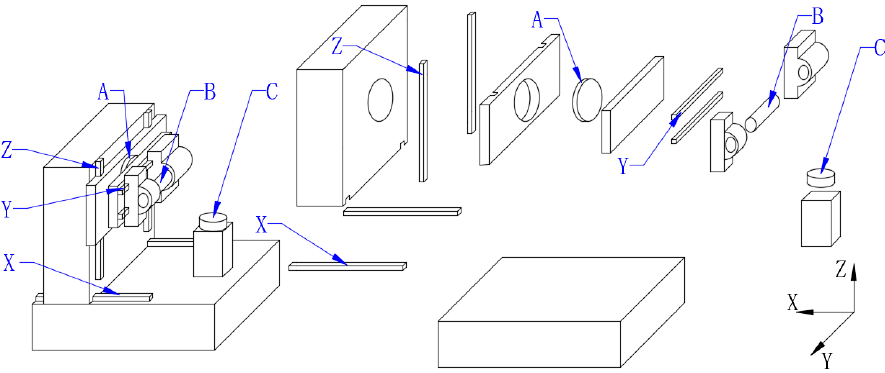
Figure 11. Decomposition of the geometric error transfer route.